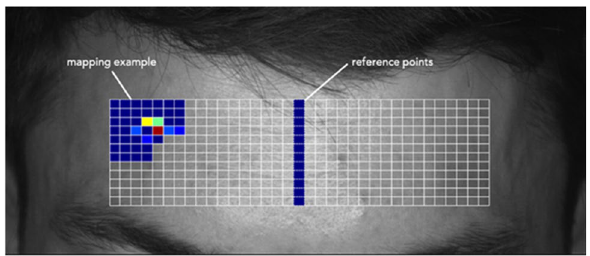
Figure 9. Example of map creation. Reference points in the matrix are placed in the middle of each row.